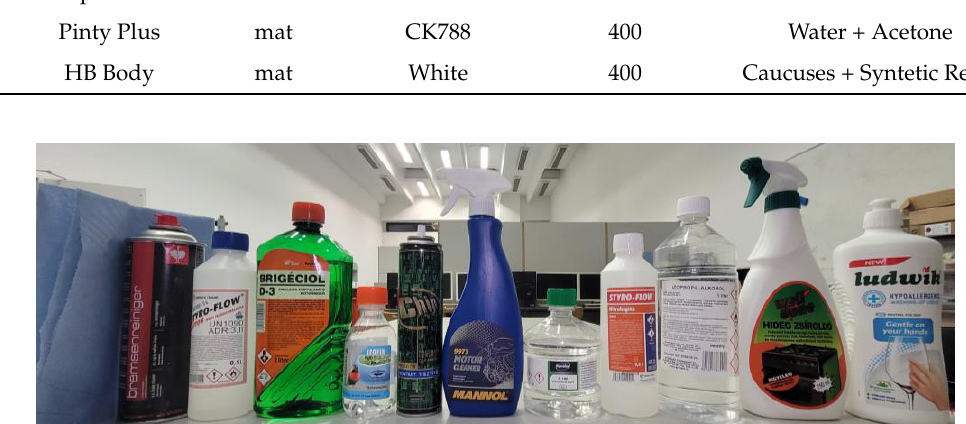
Table 2. List of paints used in the research.